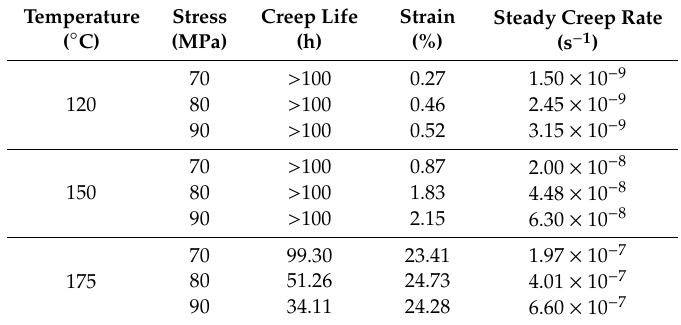
Table 2. Creep data of HRRed specimens tested at 120–175 ◦ C and under 70–90 MPa.